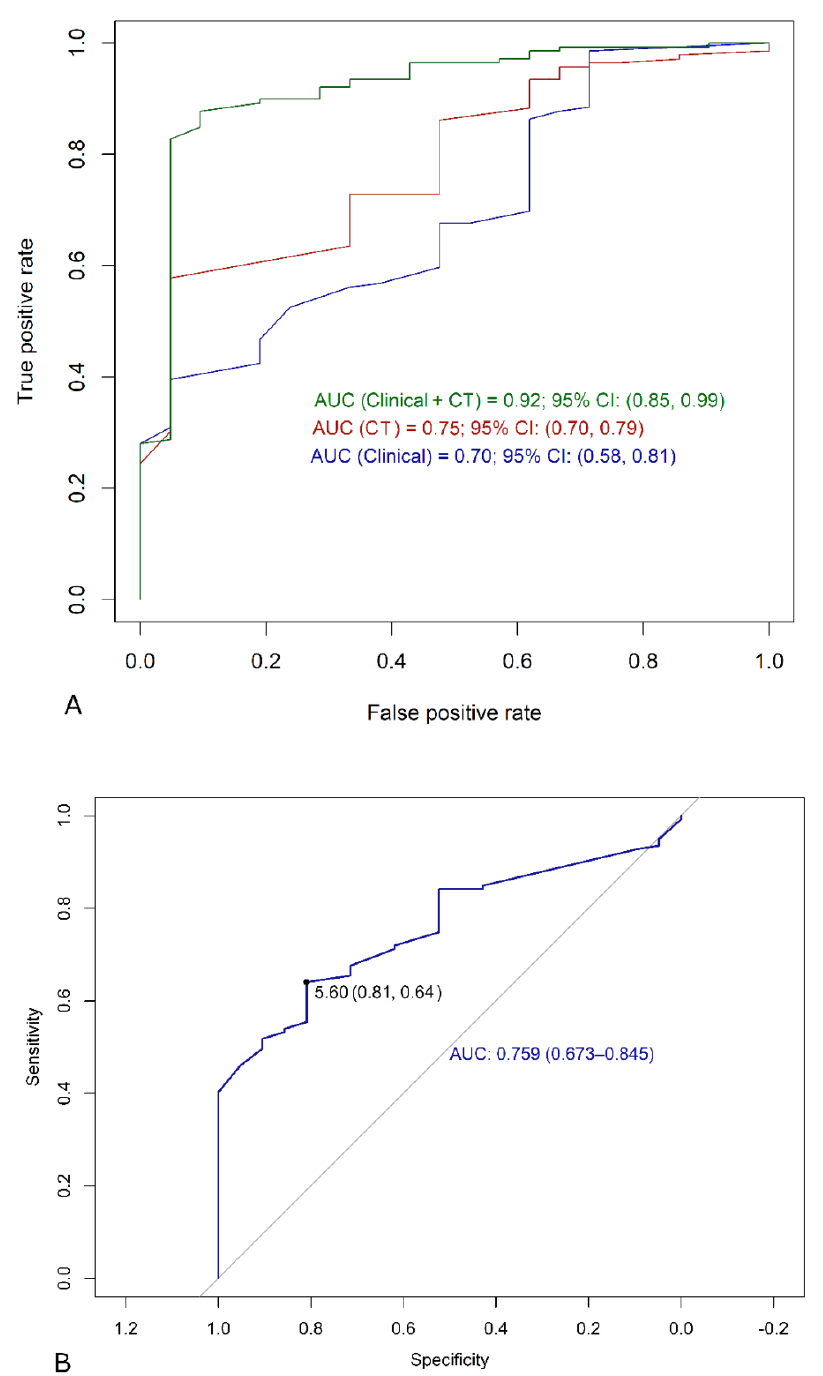
Figure 3. ( A ) Graph shows the results of C statistical analysis of multiple logistic regression models in discriminating malignant from benign nodules. The highest area under the curve (AUC) was with the combination of both clinical and CT predictors (AUC = 0.92), which was significantly higher than that of either clinical (AUC = 0.70) or CT (AUC = 0.81, both p < 0.05) alone. ( B ) Cut off calculations for nodule size.